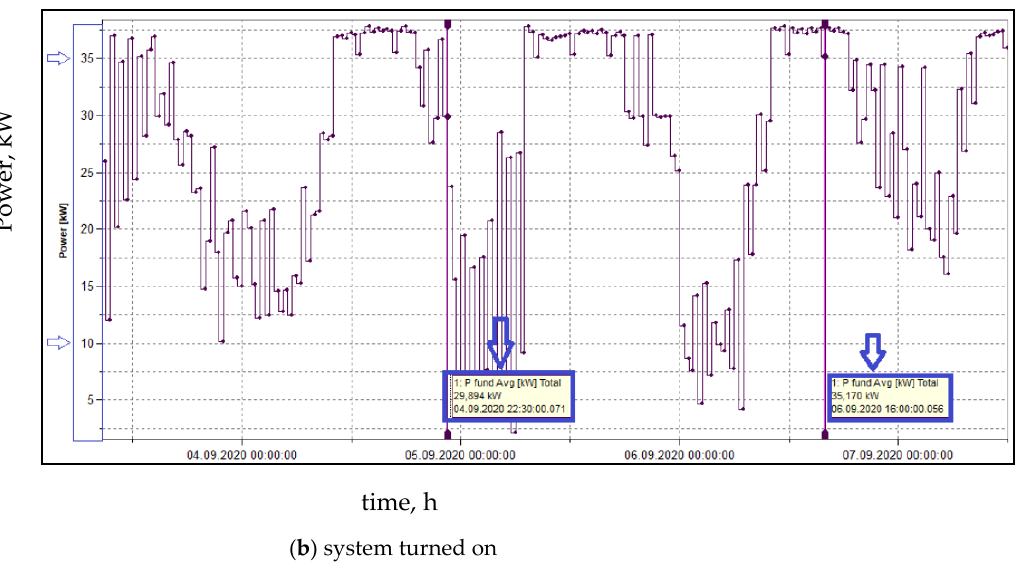
Figure 2. Fluke energy meter readings with direct evaporative cooling system turned off/turned on. Figure 2 on X-axes shows seven days time interval.